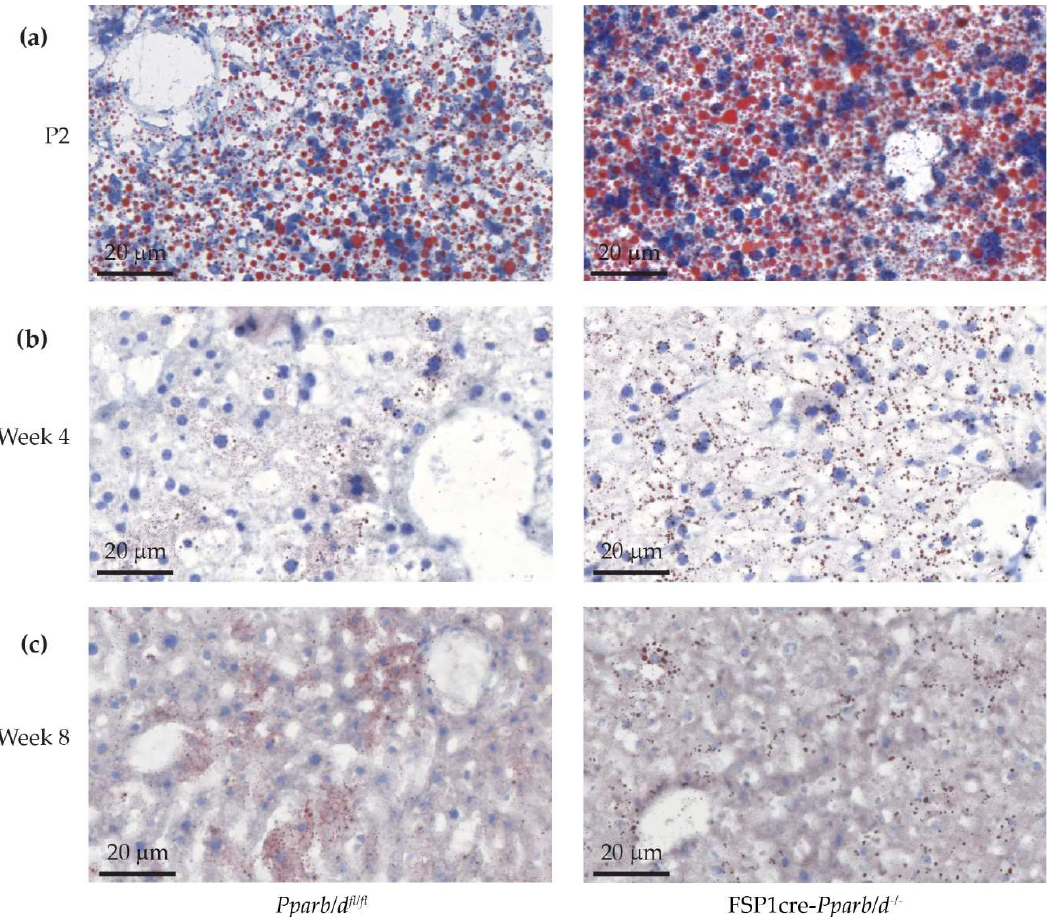
Figure 4. Oil Red O staining of liver sections from Pparb / d fl / fl and FSP1cre- Pparb / d − / − mice at three age points. Larger and more lipid droplets are observed at P2 livers in FSP1cre- Pparb / d − / − mice. There are also more droplets at week 4. (a) P2 livers. (b) Week 4 livers. (c) Week 8 livers.